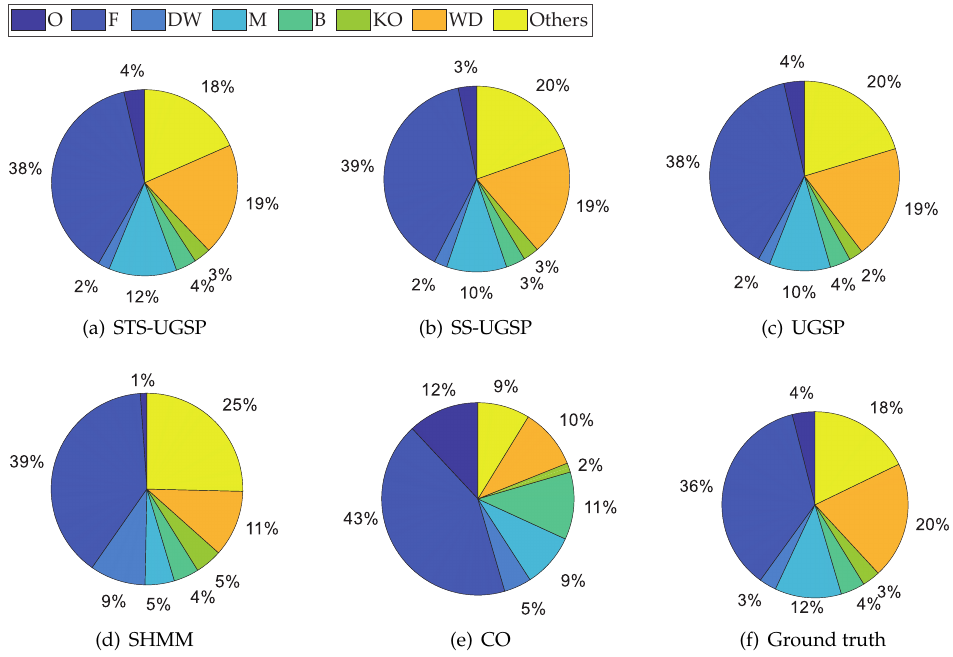
Figure 12. Pie charts of disaggregated energy shares for REDD House 1.